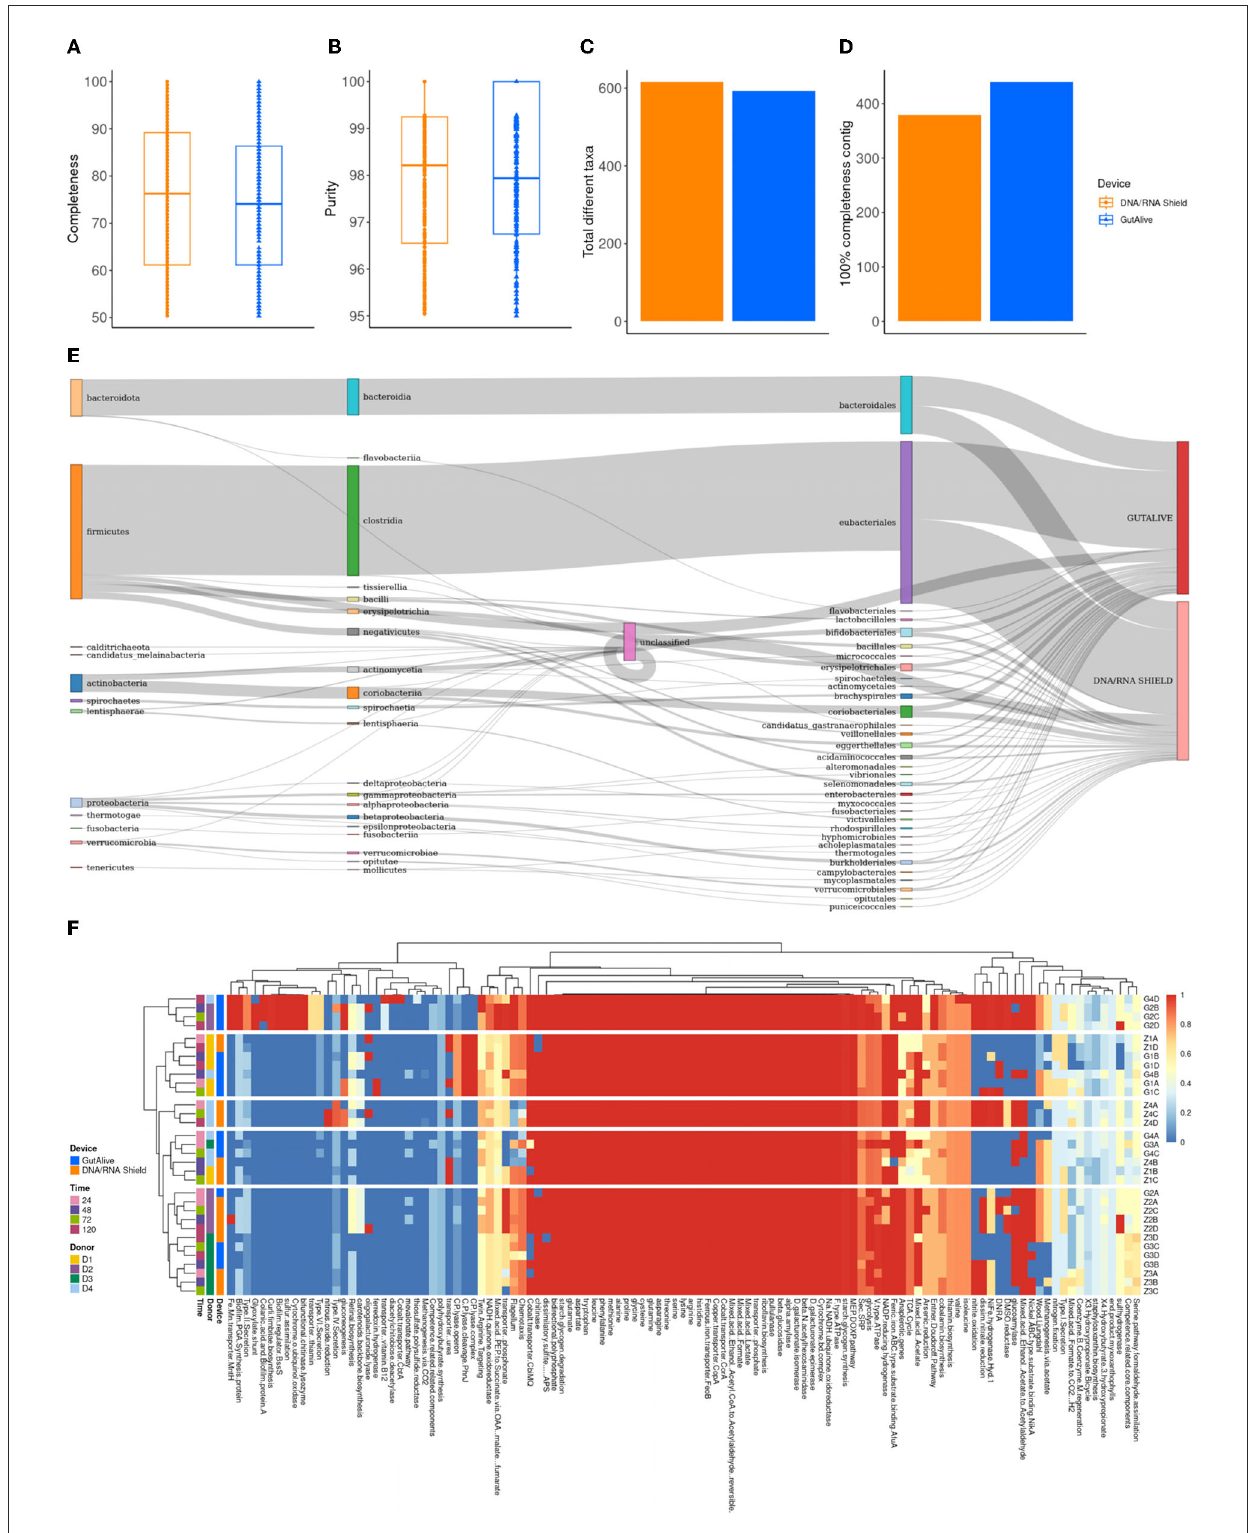
FIGURE5 Metagenome-assembled genome analysis. (A) Completeness. (B) Purity. (C) Total number of different taxa. (D) Number of contigs with 100% completeness. (E) Sankey plot from phylum to family-level. (F) Heatmap representing the functional categories of the identified metabolic